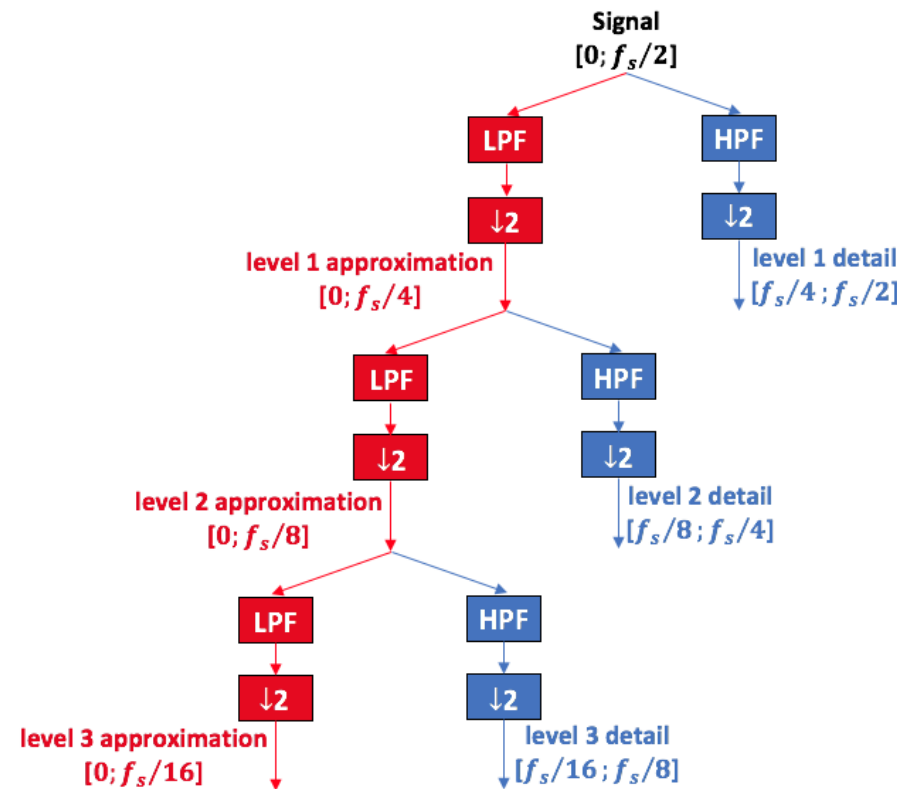
Figure 1. Schematic diagram of DWT decomposition in approximations and details obtained by dyadic filters. At each level the signal is down sampled by a factor of 2, ( ↓ 2 block). The red color stands for approximation, obtained by low pass filters (LPF block); the blue color stands for detail, obtained by high pass filters (HPF